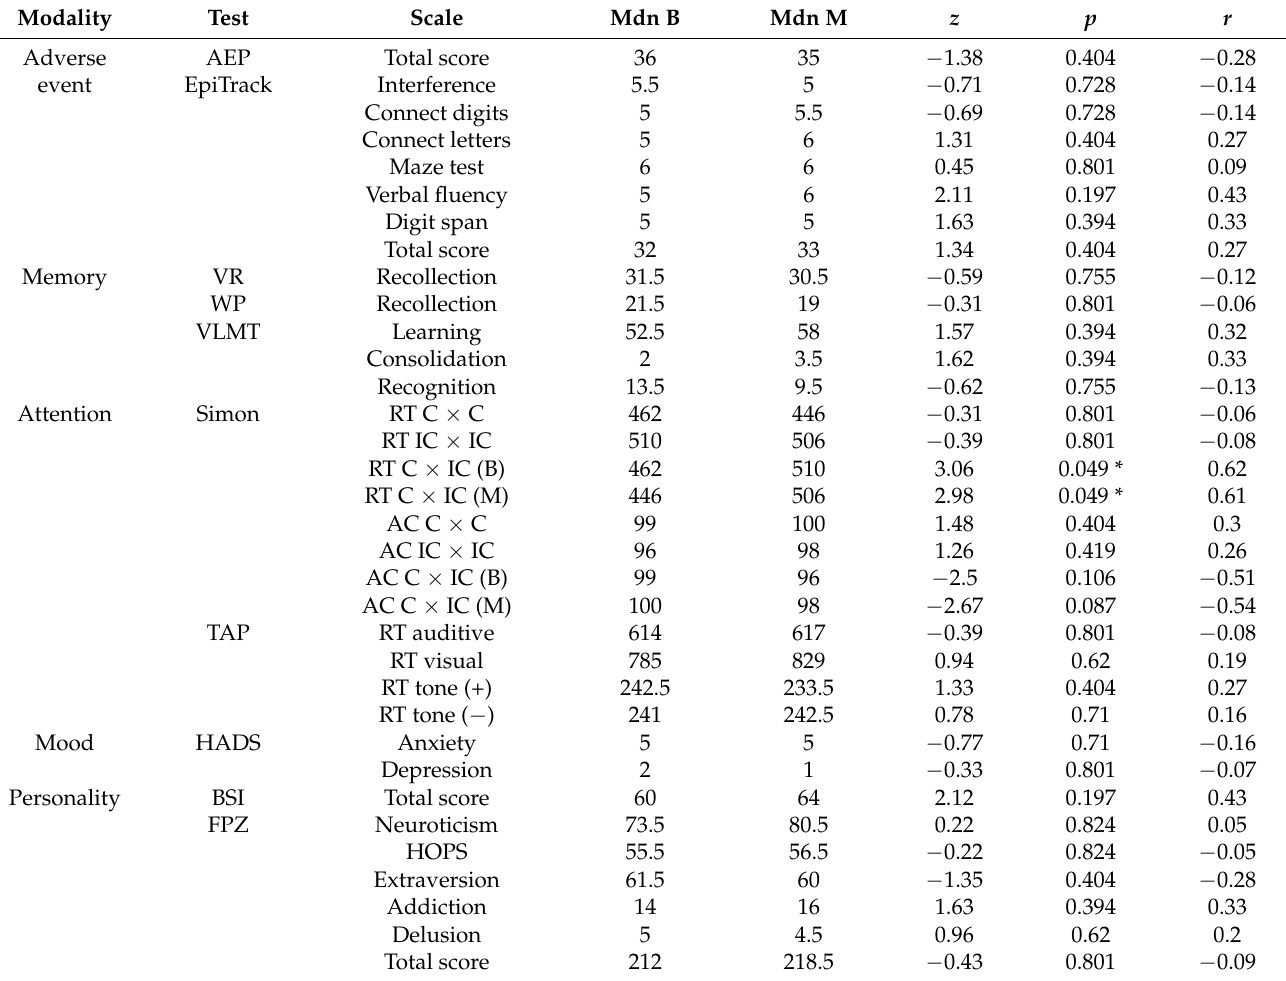
Table 1. Results of all behavioral testings (Neuropsychology and cognitive